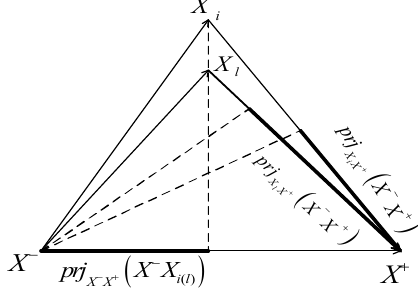
Figure 3. The closeness degree of bi-directional projection model.